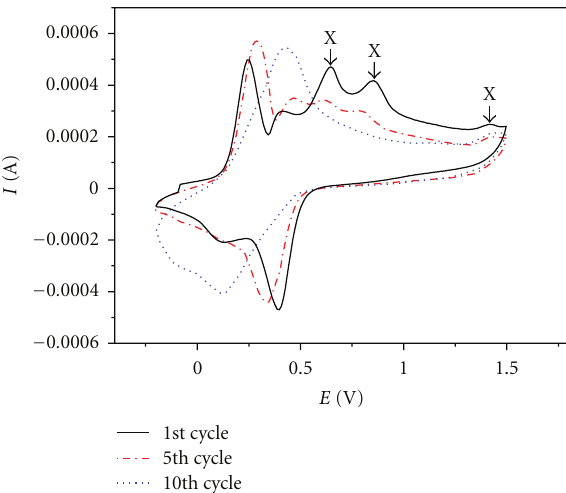
Figure 2: The details of PANI-Co(II)TATPP membrane I.d elec- tropolymerisation from DMF/aniline solution. Peaks indicated as X show an incorporation of Co(II)TATPP in PANI film during first 5 cycles.